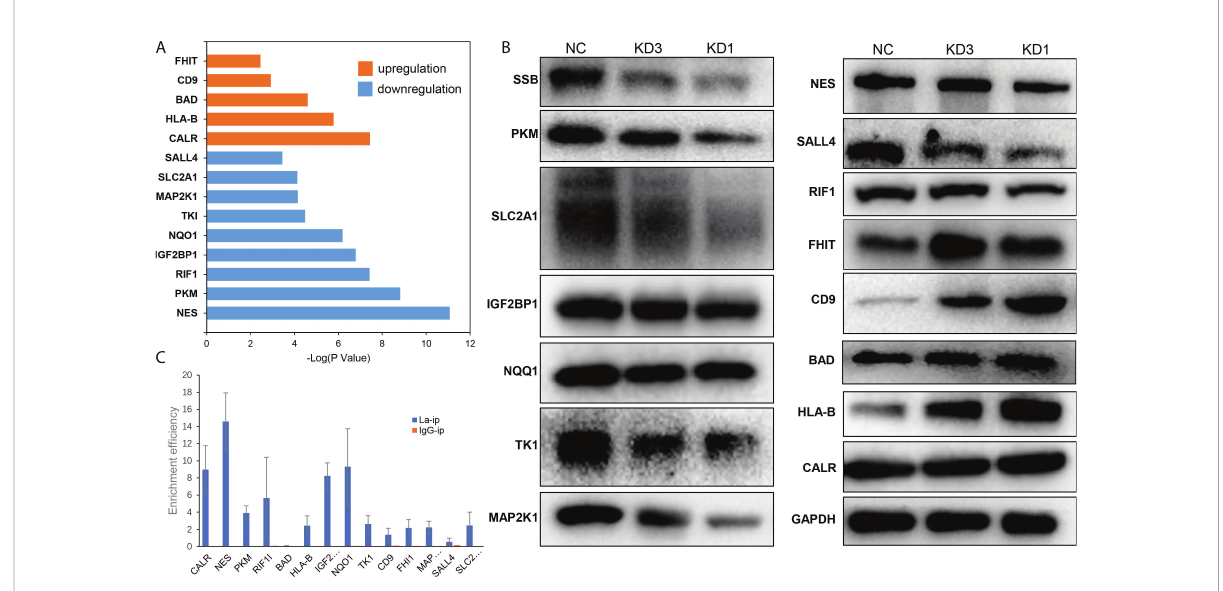
FIGURE 9 Possible downstream targets of La protein screened by RIP-seq and proteomics in A2780 cells. (A) The results showed that the relative expression of upregulated (orange) and downregulated (blue) proteins in A2780 cells after La RNA interference, and the ordinate was P value (logarithmic transformation with 10 as the base). (B) Western blot validation of La downstream targets. (C) RIP-qPCR validation of La binding to the selected